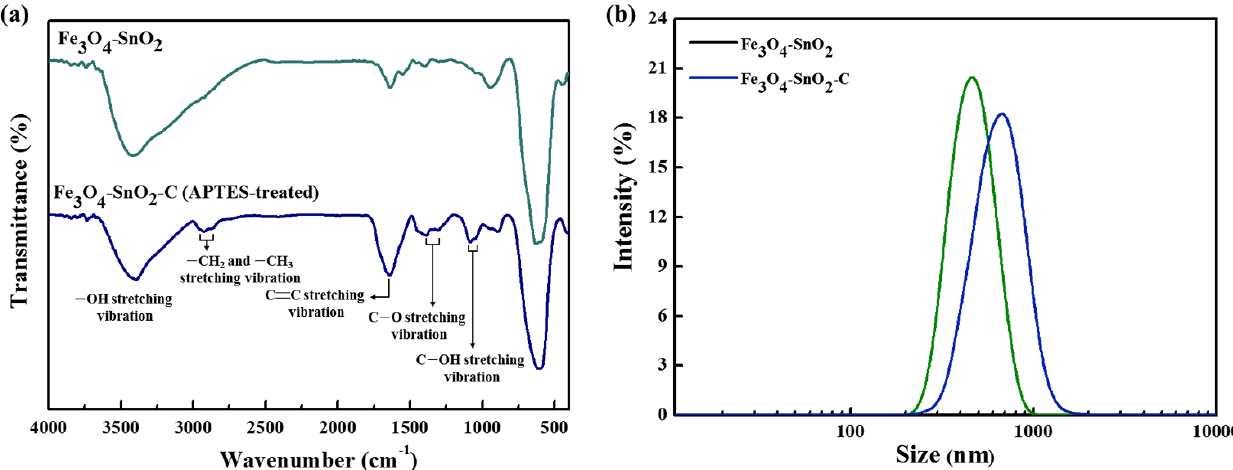
Figure 9. FTIR spectra ( a ) and particle size distribution curves ( b ) of the Fe 3 O 4 -SnO 2 and Fe 3 O 4 -SnO 2 -C nanoparticles.